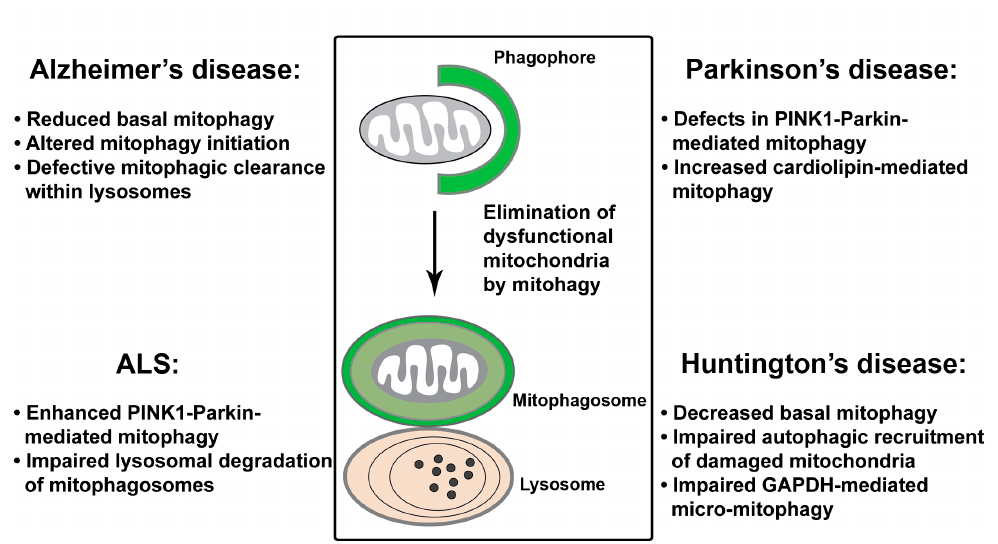
Figure 4. Mitophagy defects in neurodegenerative diseases. A growing body of evidence indicate that mitophagy function is impaired in major neurodegenerative diseases. In Alzheimer’s disease (AD), robust activation of Parkin-mediated mitophagy was observed in patient brains of familiar and sporadic AD and the cell and animal models. However, under tauopathy conditions, excessive or defective Parkin-dependent mitochondrial turnover was reported in different studies, respectively. In addition, impaired lysosomal proteolysis and reduced levels of the basal mitophagy collectively contribute to mitophagy dysfunction in AD. In Parkinson’s disease (PD), PINK1-Parkin-dependent mitophagy is necessary for the function and survival of PD-related dopaminergic neurons in response to stress/pathological stimuli. The role for increased cardiolipin-mediated mitophagy in mutant α -syn-induced mitochondrial dysfunction has also been proposed. As for amyotrophic lateral sclerosis (ALS), enhanced Parkin-mediated mitophagy was demonstrated in an ALS mouse model. Mitophagy defects and mitochondrial pathology are also attributed to lysosomal deficit in ALS affected motor neurons. In Huntington’s disease (HD), decreased basal levels of mitophagy, defects in autophagic recognition and recruitment of damaged mitochondria, and impaired GAPDH-mediated micro-mitophagy lead to pathological mitophagy and mitochondrial dysfunction.